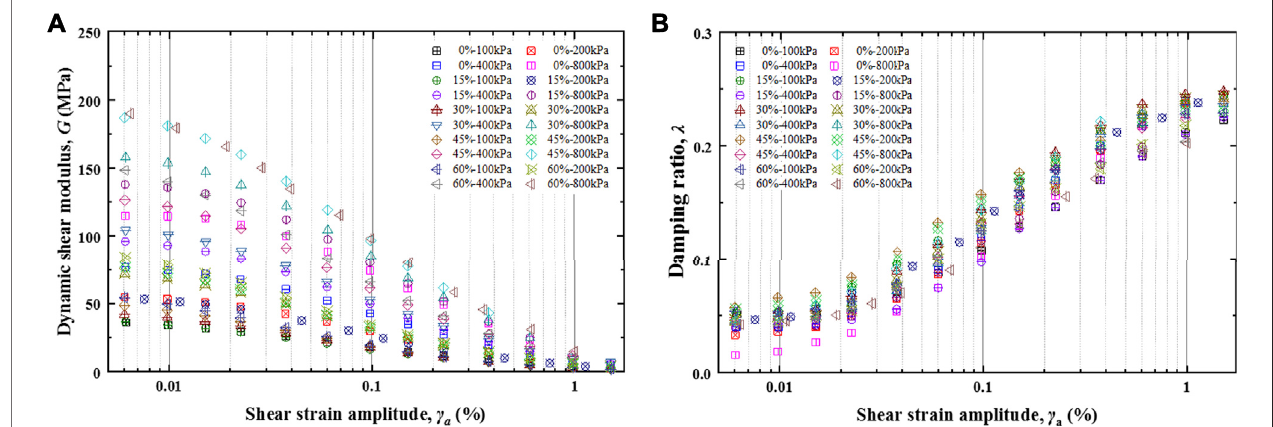
FIGURE 1 | G and λ of SRM with different VBPs and